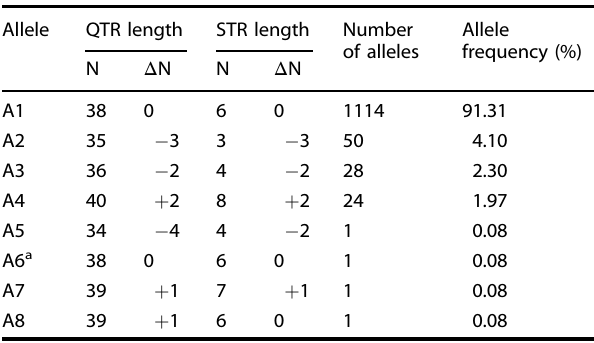
Table 1. Hexanucleotide repeat allele frequencies in TCERG1